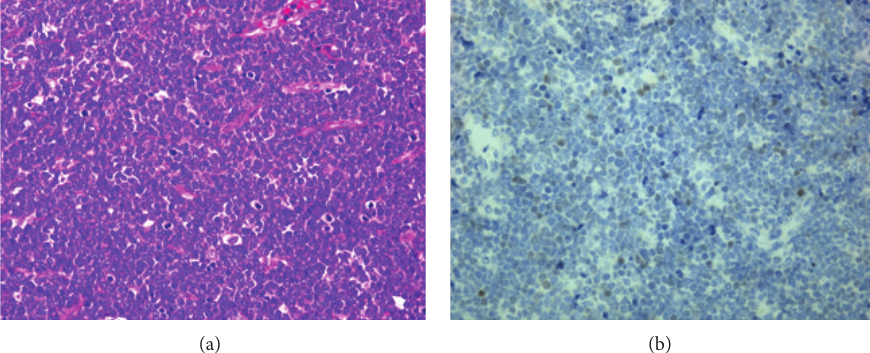
Figure 3: Histopathological examinations. T-cell lymphoblastic lymphoma. (a) The tumor was composed of medium sized lymphoblast with inconspicuous nucleoli (H&E; × 40). (b) The tumor cells were TdT